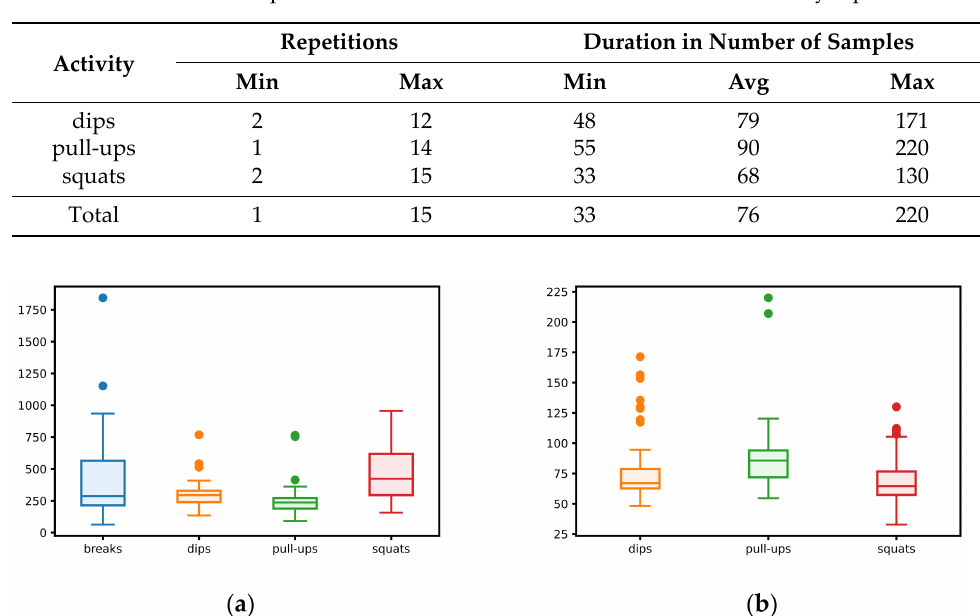
Table 4. The number of repetitions and the statistics of the duration of one activity repetition.